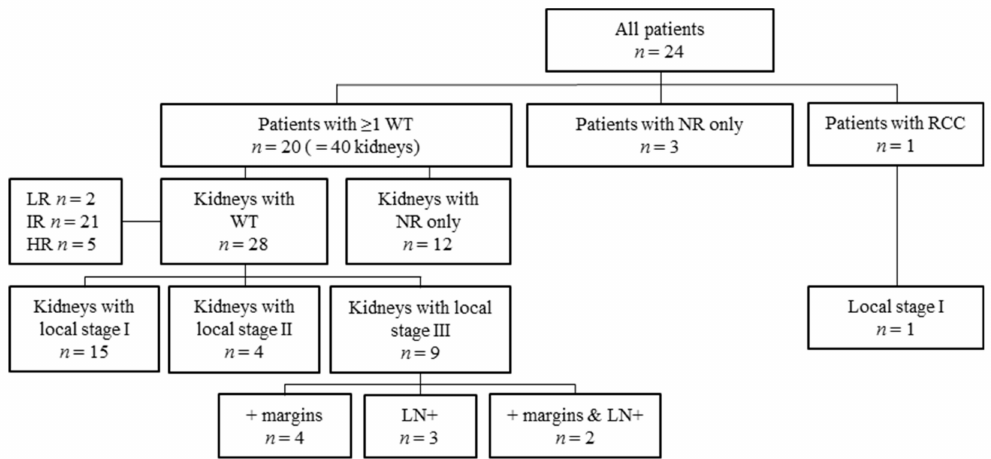
Figure 4. Flow diagram of stage and histology per kidney. n: number; WT: Wilms tumor, NR: nephrogenic rests; RCC: renal cell carcinoma; LR: low-risk histology; IR: intermediate-risk histology; HR: high-risk histology; + margins: positive resection margins; LN+: lymph nodes positive for tumor